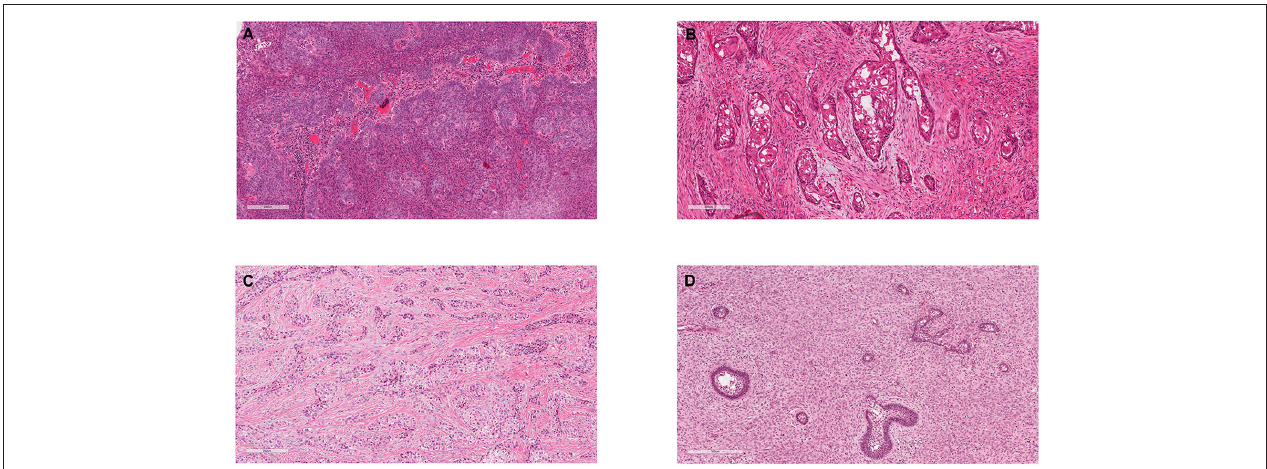
FIGURE 1 | Exemplar histology of the commonest malignant odontogenic tumours. (A) Ameloblastic carcinoma. This was a maxillary lesion and the patient presented with a lymph node metastasis within 6 months. (B) Primary Intraosseous Carcinoma NOS (historically synonymous with PIOSCC) from the angle of the mandible. (C) Clear Cell Odontogenic Carcinoma, which showed re-arrangement of the EWSR1 gene. (D) Ameloblastic